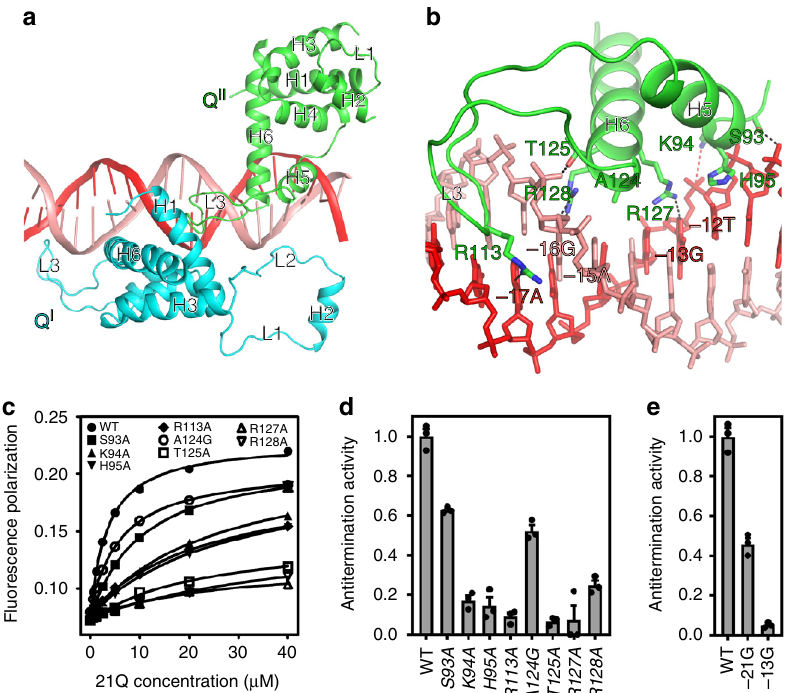
Fig. 3 21Q-QBE interactions that mediate 21Q engagement. a Q I and Q II contact QBE from different faces of the DNA helix. Cyan, Q I ; green, Q II ; salmon, nontemplate strand; red, template strand. b Interactions between Q II and QBE subsite 2. Salmon sticks, nontemplate strand; red sticks, template strand; black dashed lines, H-bonds ( ≤ 3.5 Å); red dashed line, salt bridge ( ≤ 4.5 Å). c Effects on 21Q-QBE binding af fi nity of substitutions of H5, H6, and L3 (mean ± SEM; 3 determinations). d Effects on antitermination of substitutions of H5, H6, and L3 (mean ± SEM; 3 determinations). e Effects on antitermination of substitutions in QBE subsite 1 (position − 21) and subsite 2 (position − 13), respectively (mean ± SEM; 3 determinations). Error bars represent mean ± SEM out of n = 3 experiments. Source data are provided as a Source Data fi